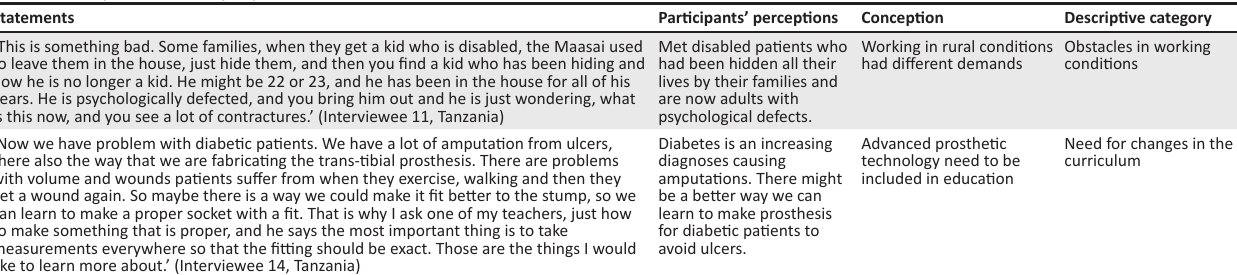
TABLE 1: Example of data analysis